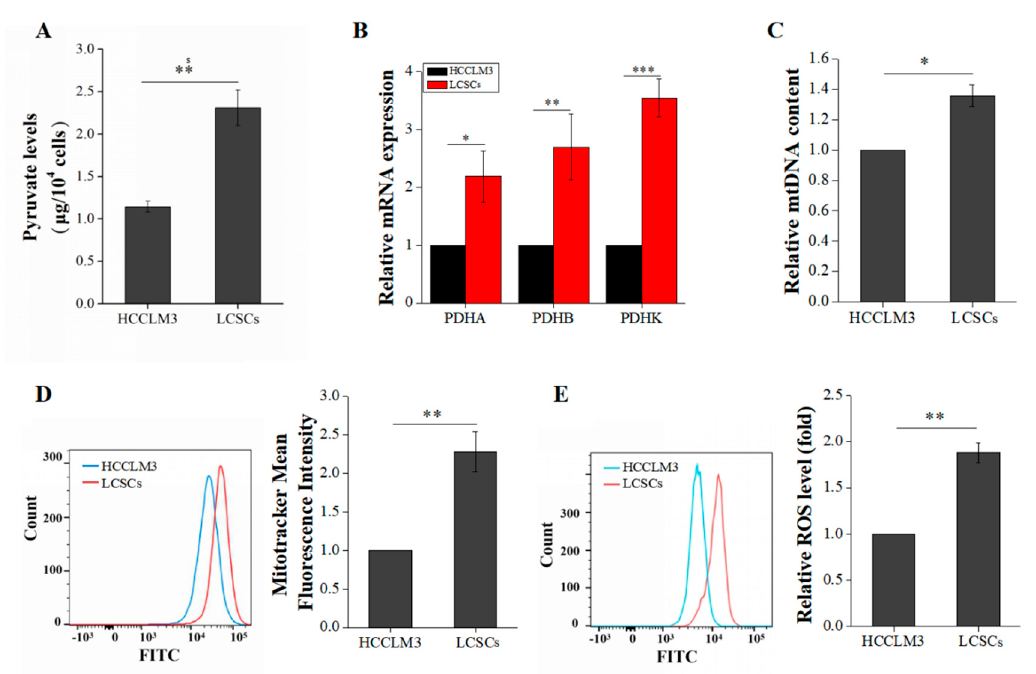
Figure 3. Comparison of oxidative phosphorylation (OXPHOS) between HCCLM3 and LCSCs. ( A ) Comparison of pyruvate levels. ( B ) Comparison of the pyruvate dehydrogenase complex (PDHC) expression. ( C ) Measurement of the mtDNA copy number. ( D ) Measurement of the mitochondrial mass. ( E ) Measurement of the reactive oxygen species (ROS) level. The values are presented as the means ± SD of three independent experiments. n = 3; * p < 0.05; ** p < 0.01; and *** p < 0.001.